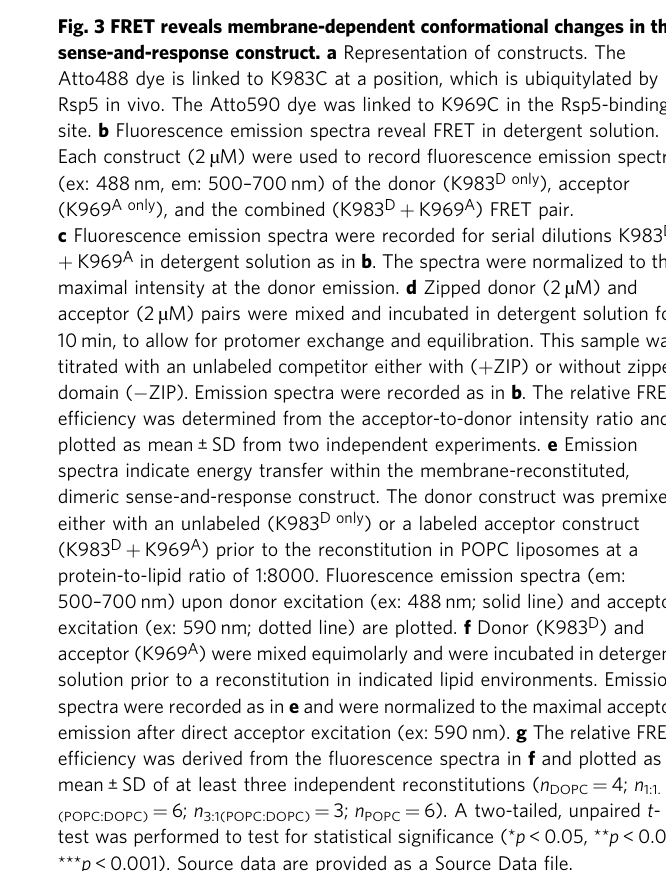
Fig. 3 FRET reveals membrane-dependent conformational changes in the sense-and-response construct. a Representation of constructs. The Atto488 dye is linked to K983C at a position, which is ubiquitylated by Rsp5 in vivo. The Atto590 dye was linked to K969C in the Rsp5-binding site. b Fluorescence emission spectra reveal FRET in detergent solution. Each construct (2 µ M) were used to record fl uorescence emission spectra (ex: 488 nm, em: 500 – 700 nm) of the donor (K983 D only ), acceptor (K969 A only ), and the combined (K983 D + K969 A ) FRET pair. c Fluorescence emission spectra were recorded for serial dilutions K983 D + K969 A in detergent solution as in b . The spectra were normalized to the maximal intensity at the donor emission. d Zipped donor (2 µ M) and acceptor (2 µ M) pairs were mixed and incubated in detergent solution for 10 min, to allow for protomer exchange and equilibration. This sample was titrated with an unlabeled competitor either with ( + ZIP) or without zipper domain ( − ZIP). Emission spectra were recorded as in b . The relative FRET ef fi ciency was determined from the acceptor-to-donor intensity ratio and plotted as mean ± SD from two independent experiments. e Emission spectra indicate energy transfer within the membrane-reconstituted, dimeric sense-and-response construct. The donor construct was premixed either with an unlabeled (K983 D only ) or a labeled acceptor construct (K983 D + K969 A ) prior to the reconstitution in POPC liposomes at a protein-to-lipid ratio of 1:8000. Fluorescence emission spectra (em: 500 – 700 nm) upon donor excitation (ex: 488 nm; solid line) and acceptor excitation (ex: 590 nm; dotted line) are plotted. f Donor (K983 D ) and acceptor (K969 A ) were mixed equimolarly and were incubated in detergent solution prior to a reconstitution in indicated lipid environments. Emission spectra were recorded as in e and were normalized to the maximal acceptor emission after direct acceptor excitation (ex: 590 nm). g The relative FRET ef fi ciency was derived from the fl uorescence spectra in f and plotted as mean ± SD of at least three independent reconstitutions ( n DOPC = 4; n 1:1. = 6; n = 3; n = 6). A two-tailed, unpaired t - 3:1(POPC:DOPC) POPC (POPC:DOPC) test was performed to test for statistical signi fi cance (* p < 0.05, ** p < 0.01, *** p < 0.001). Source data are provided as a Source Data fi